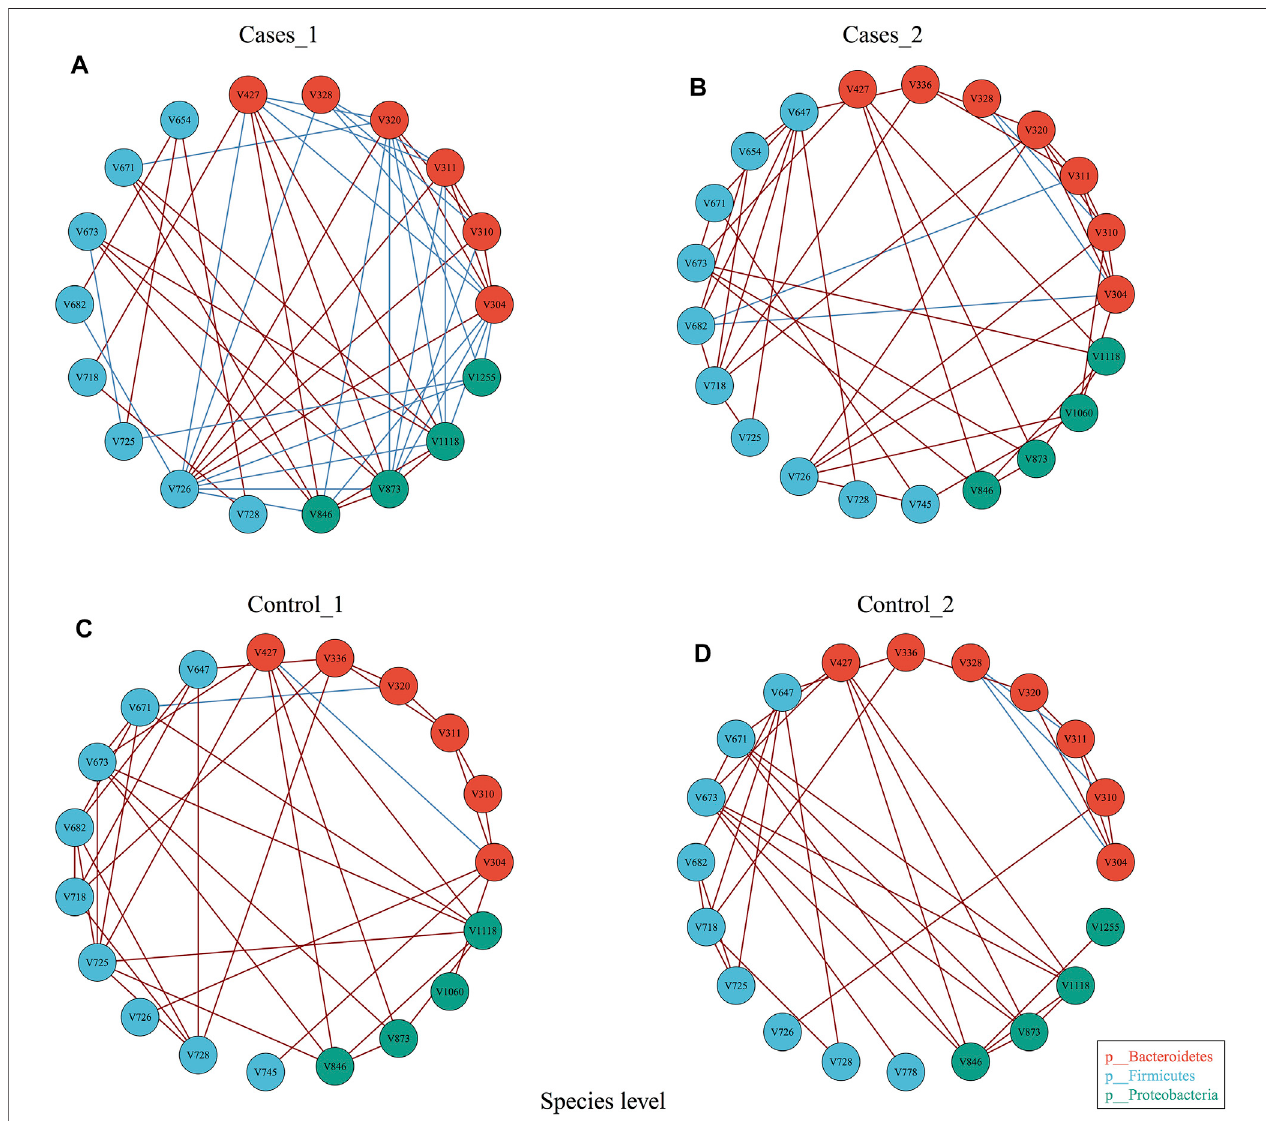
FIGURE 3 | Co-occurrence analysis of bacterial interaction under different dietary pattern and MetS